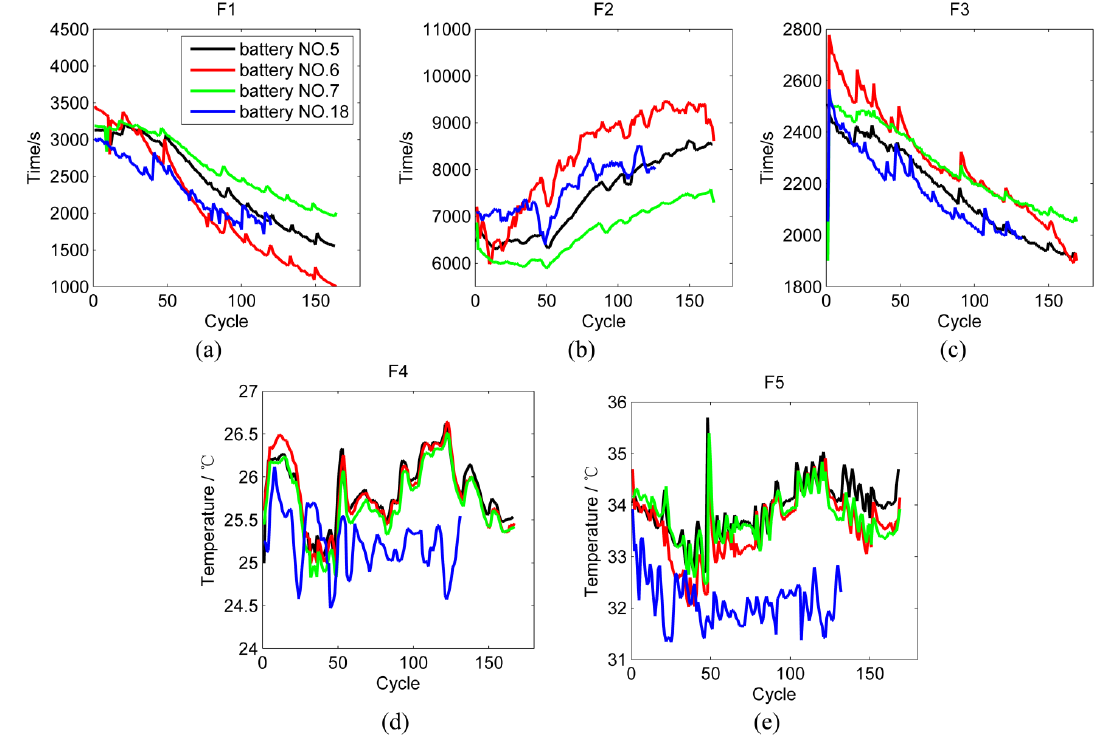
Figure 5. The curves of the first five features of batteries in the first batch. ( a ) Feature F 1 ; ( b ) Feature F 2 ; ( c ) Feature F 3 ; ( d ) Feature F 4 ; ( e ) Feature F 5 .